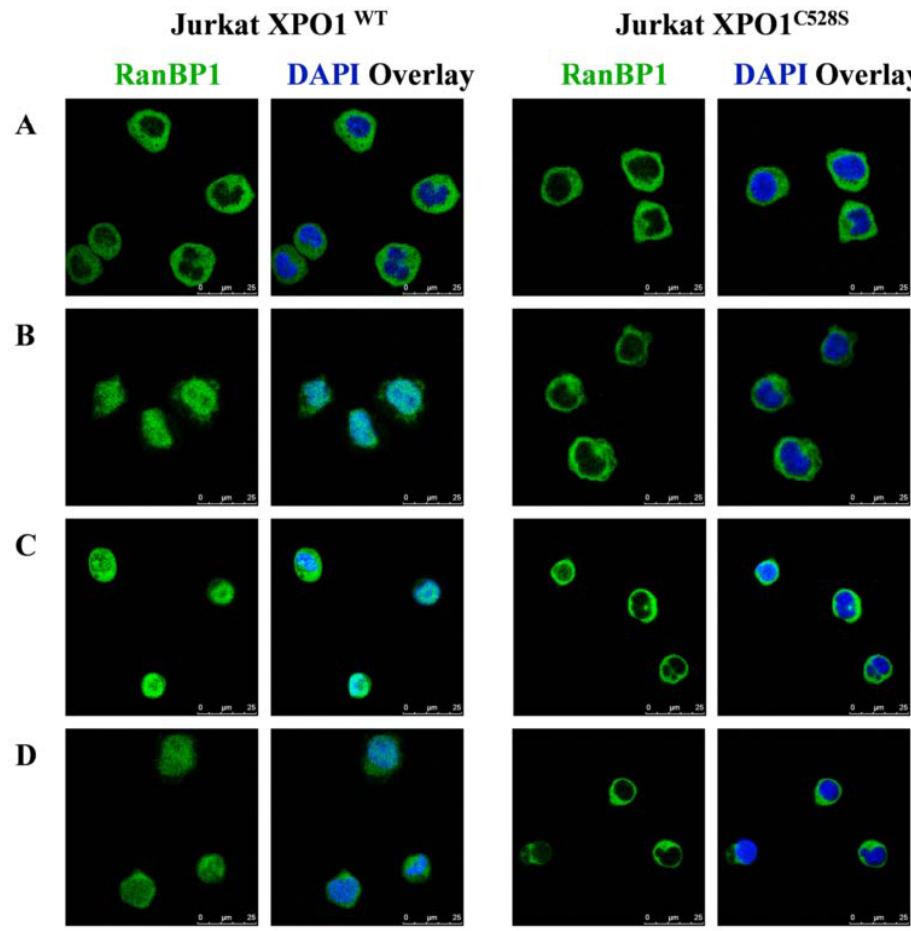
Figure 4. XPO1-mediated nuclear export of RanBP1 cargo protein. ( A ) Endogenous RanBP1 cargo protein (green) localized in the cytoplasm of untreated wild-type and mutant XPO1 C528S Jurkat cells; ( B ) 3 h after treatment with 1 µ M KPT-330 (Selinexor), RanBP1 accumulates in the nucleus of wild- type cells (left) but remains localized in the cytoplasm of mutant XPO1 C528S cells (right); ( C , D ) 3 h after treatment with 4 µ M of prototype compounds 9 or 10 , respectively, nuclear accumulation